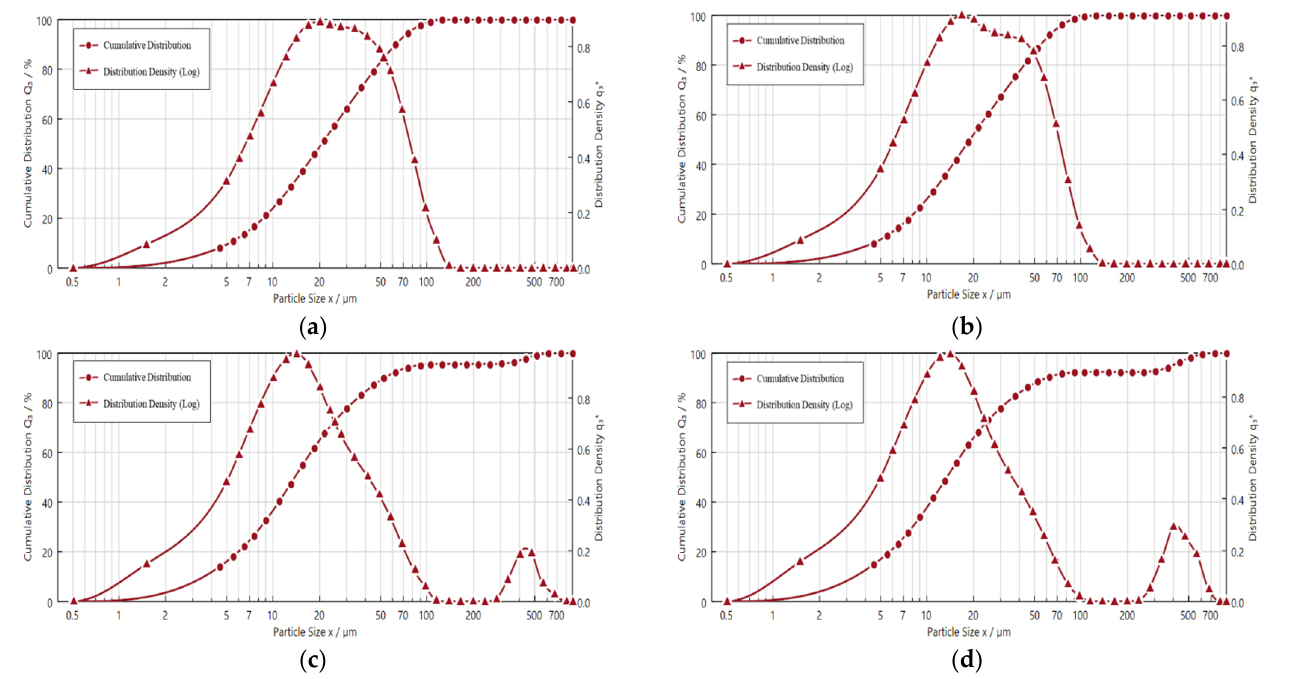
Figure 9. Particle size distribution of deposited PM; Test IDs ( a ) 1, ( b ) 2, ( c ) 3, and ( d ) 4.